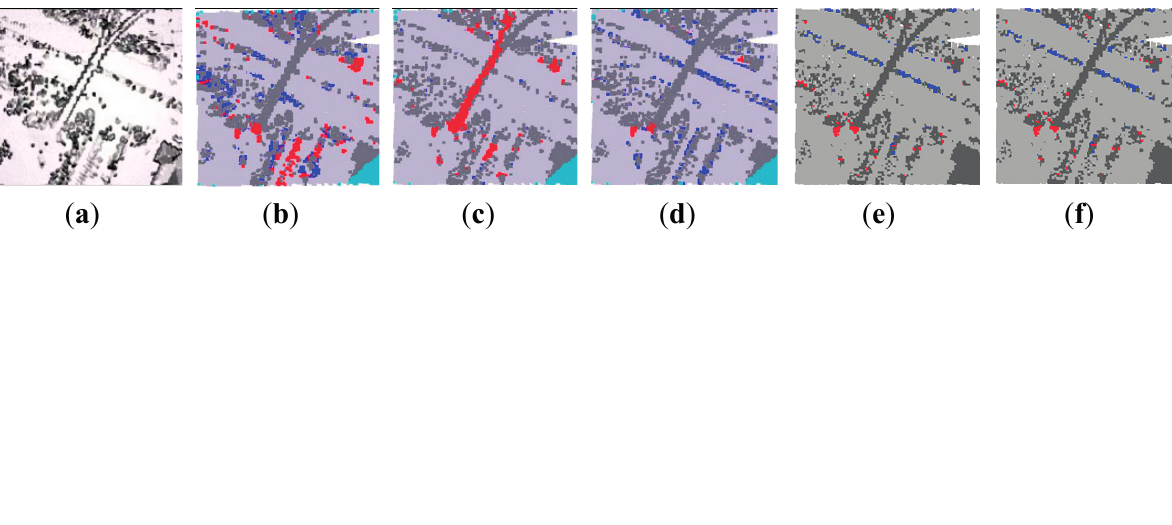
Figure 13. Comparison of the filtering results of different methods for sample 21: ( a ) DSM generated from the raw point clouds; ( b ) Sohn; ( c ) Axelsson; ( d ) Pfeifer; ( e ) Li et al. [38]; ( f ) This